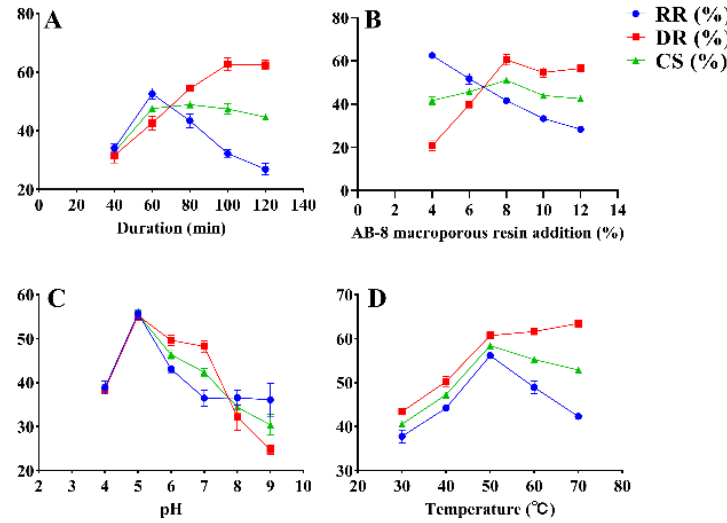
Figure 1. SFEs for the decolorization of RGP using AB-8 macroporous resin. DR: decolorization rate (%); RR: retention rate (%); CS: composite score (%). ( A – D ): duration, AB-8 macroporous resin addition, pH, temperature.